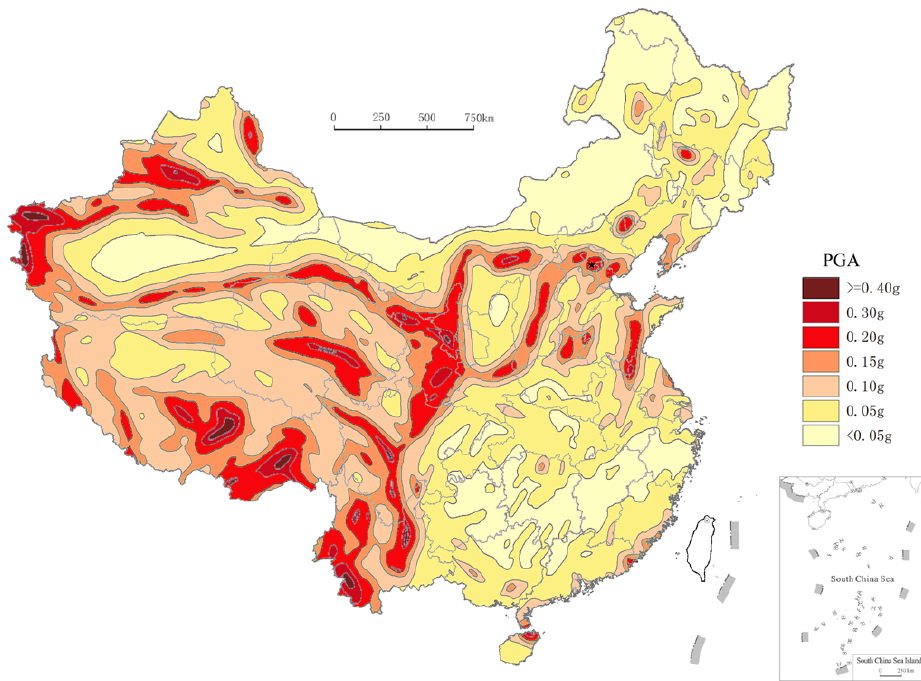
Fig. 2. Seismic ground motion parameter zonation map of China. Table 1. The vulnerability matrix of industrial factory buildings. Collapse Serious damage Medium damage Slight damage Basically intact P(D j | R i = 0 . 05) 0 0 0.07 0.2 0.73 P(D j | R i = 0.1–0.15) 0 0.03 0.12 0.28 0.57 P(D j | R i = 0.20–0.3) 0.02 0.15 0.31 0.28 0.24 P(D j | R i > = 0.4) 0.05 0.25 0.4 0.2